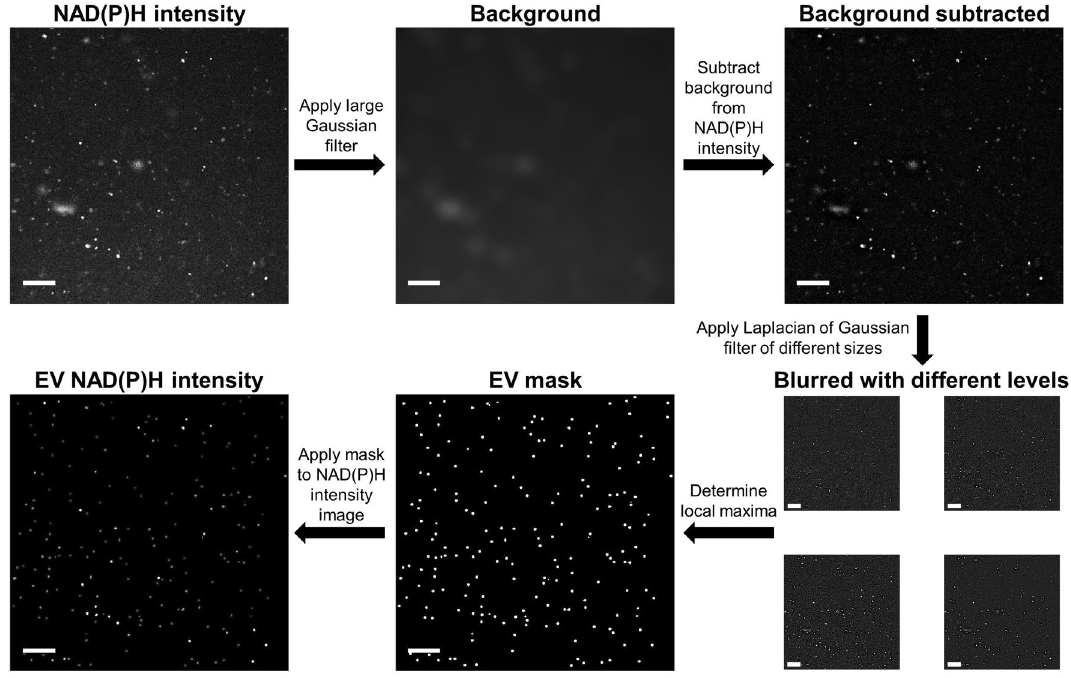
Figure 2. Schematic of extracellular vesicle (EV) segmentation using a blob detection algorithm. First, a large Gaussian filter was applied and then subtracted from the original intensity image to adjust for nonuniformity in the background. Next, Laplacian of Gaussian filters of different sizes were applied to the image to highlight local maxima of varying sizes. A 3D local maxima filter was applied to a stack of images filtered at different levels to create a mask for EVs of different sizes and a threshold was applied to only segment maxima that exceed the background noise. Finally, this binary mask was multiplied by the original intensity image to display the intensity of each segmented EV. Scale bars represent 20